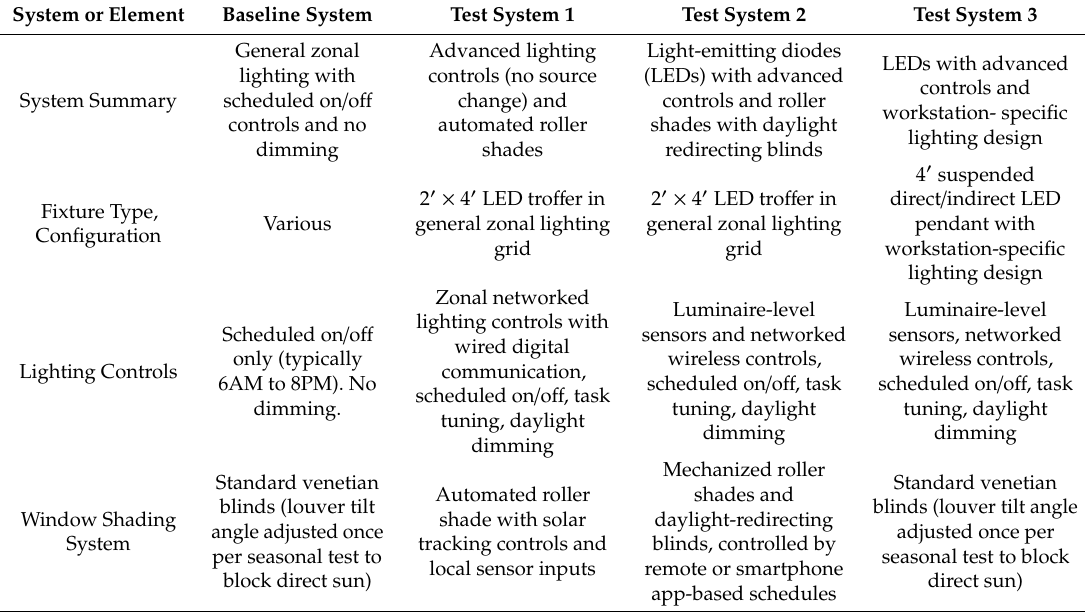
Table 1. System descriptions and